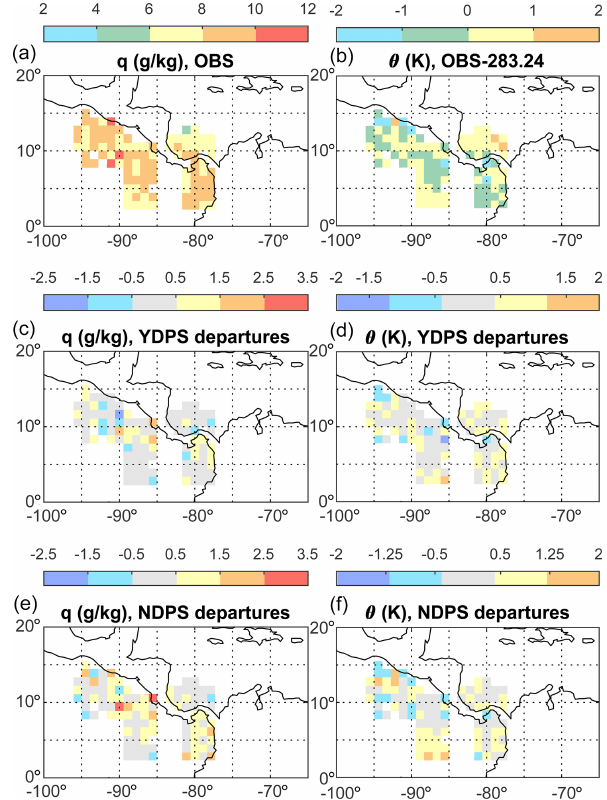
Figure 2. The horizontal distribution of mean departures (defined in Eq. 1) for (a, c, e) zonal and (b, d, f) meridional wind, at 700hPa. (a, b) Mean dropsonde observations. (c, d) Departures of the control (YDPS) experiment. (e, f) Departures of the denial (NDPS) experi- ment.